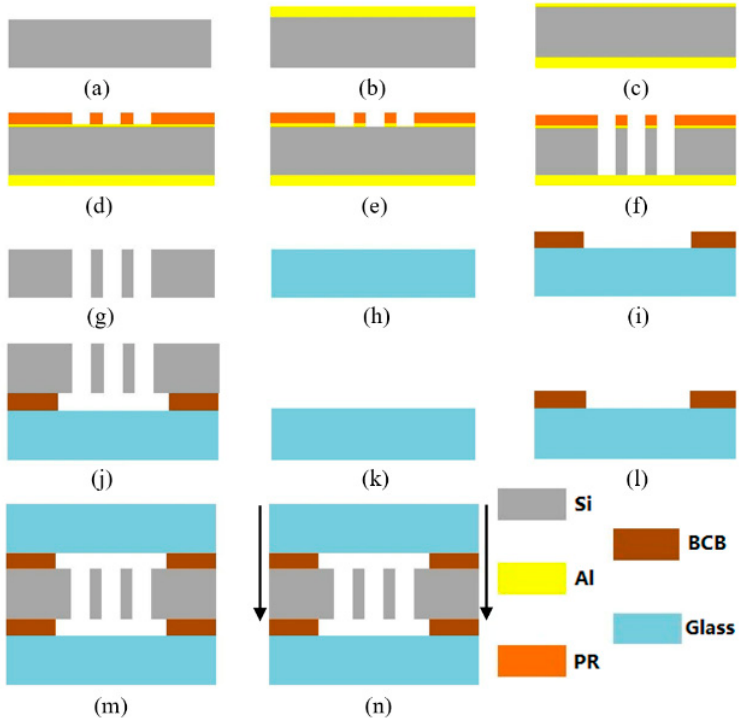
Figure 10. Micromachining process of silicon-based MEMS S&A system ( a ) Back-up; ( b ) Physical Vapor Deposition (PVD) Al 2um; ( c ) PVD Al 0.2um; ( d ) Structural lithography; ( e ) Corroded aluminum; ( f ) Deep Reactive Ion Etching (DRIE); ( g ) Degumming; ( h ) Back-up; ( i ) BCB Lithography; ( j ) BCB bond; ( k ) Buck-up; ( l ) BCB Lithography; ( m ) BCB bond; ( n ) Scribing.